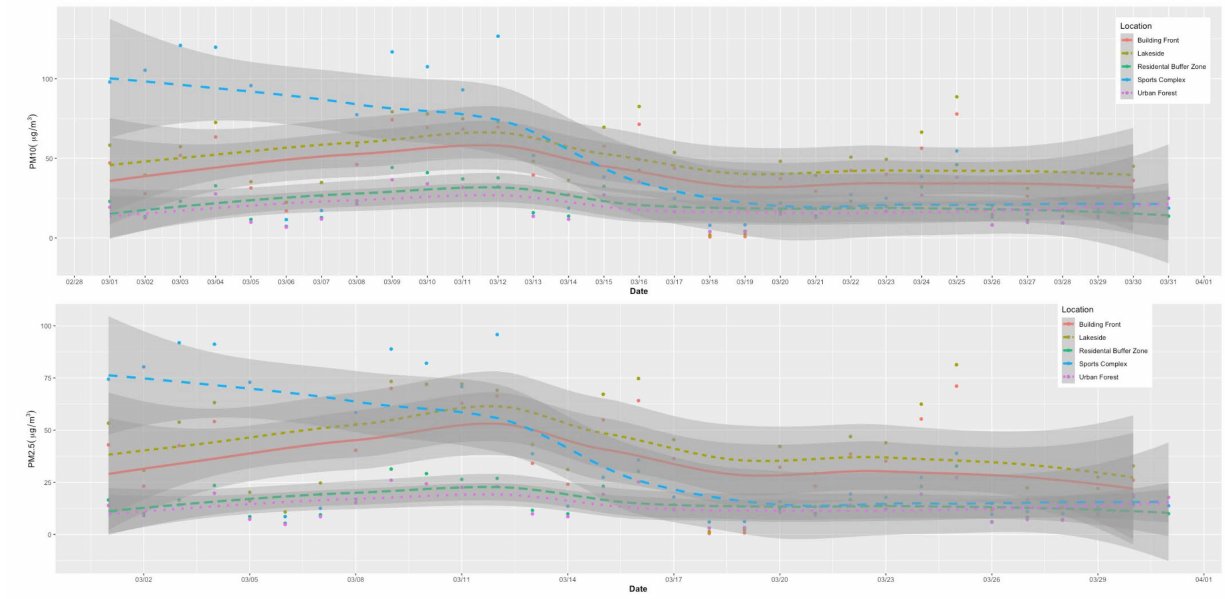
Figure 9. Time-series analysis of PM 10 and PM 2.5 concentration levels at the five locations in March